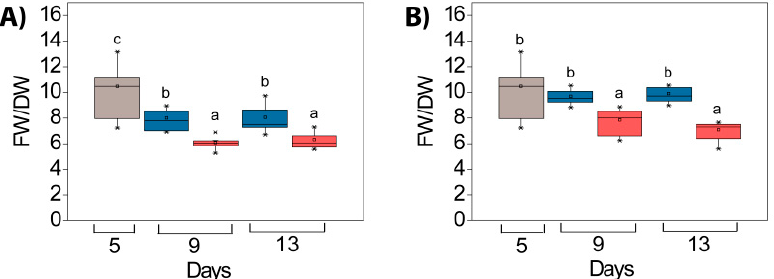
Figure 8. Fresh and dry weight ratio (FW/DW) in P. zonale leaves before (5 d, grey) and after four (9 d) and eight days (13 d) of high light exposure (HL, 800 µmol m –2 s –1 , red bars) compared to plants exposed to low light (LL, 180 µmol m –2 s –1 , blue bars) at ( A ) optimal temperature of 25 °C ( HL ) and ( B ) lower temperature of 18 °C ( Cold + HL ). Values are shown in µmol g –1 FW ± SE, n = 6–15. Different letters indicate statistically significant differences between different PAR intensities, time points, and leaf tissues ( p < 0.05) according to Tukey’s post hoc test.